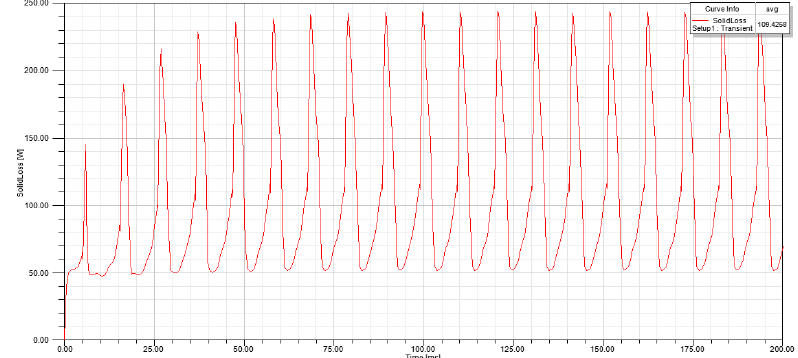
Figure 20. Time domain curve of core loss.